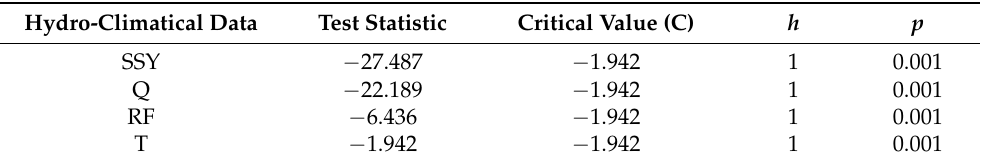
Table 3. ADF test for checking the stationary trend of data . Hydro-Climatical